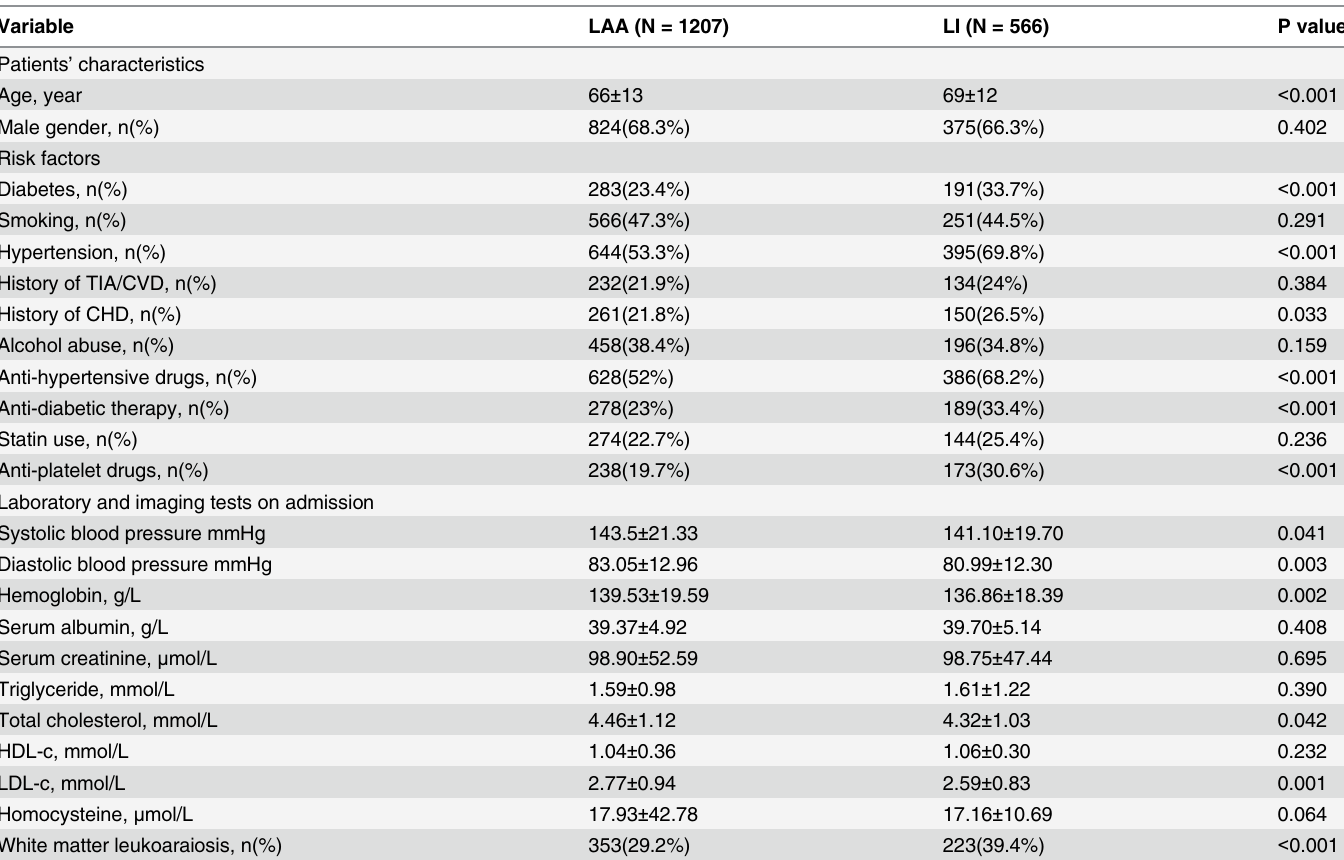
Table 2. The clinical characteristics of LI patients and LAA patients.